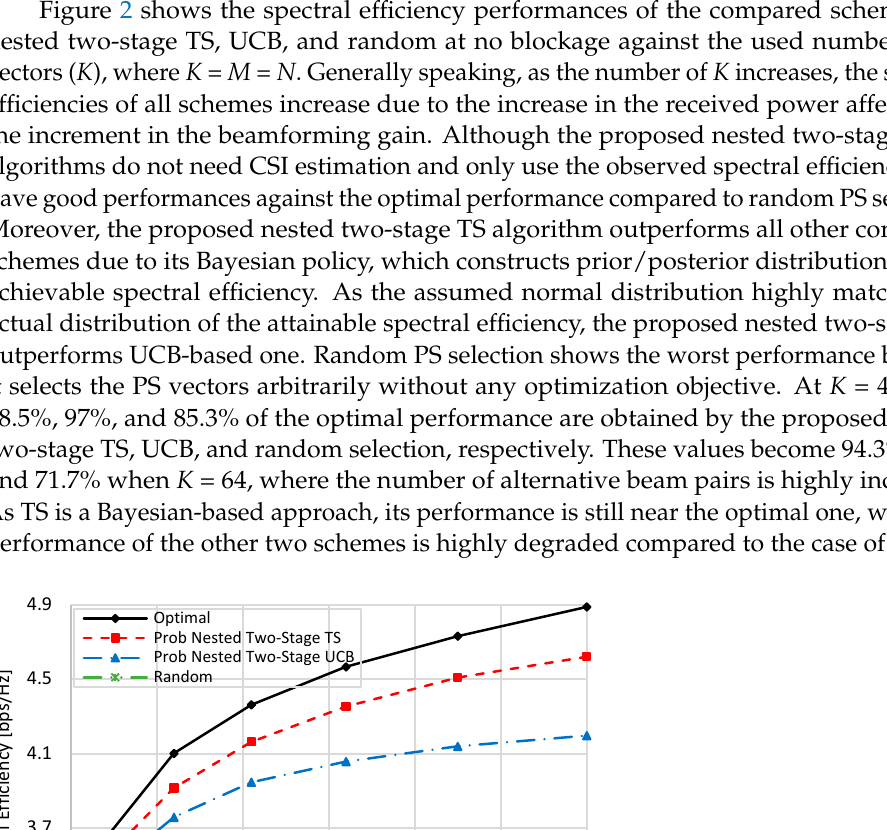
Table 1. Simulation parameters.